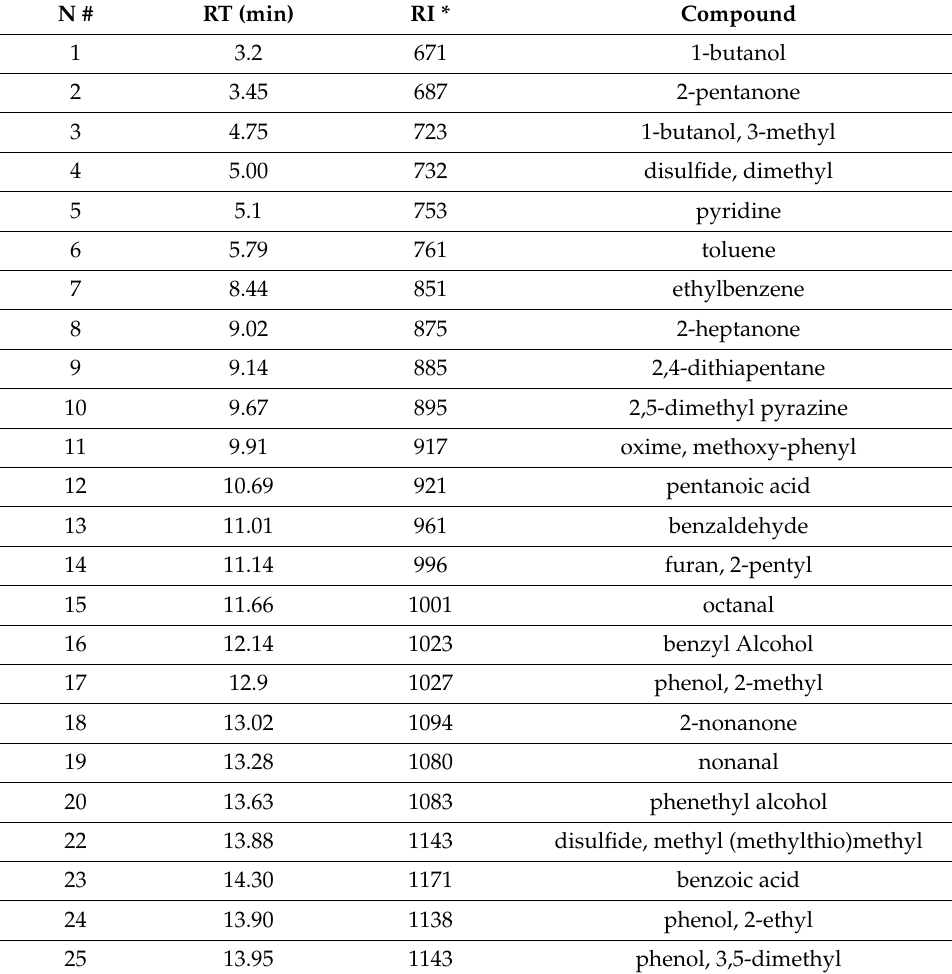
Table 3. List of the VOCs secreted by surgical resected colon mucosa tissues of CRC patients. N # RT (min) RI *